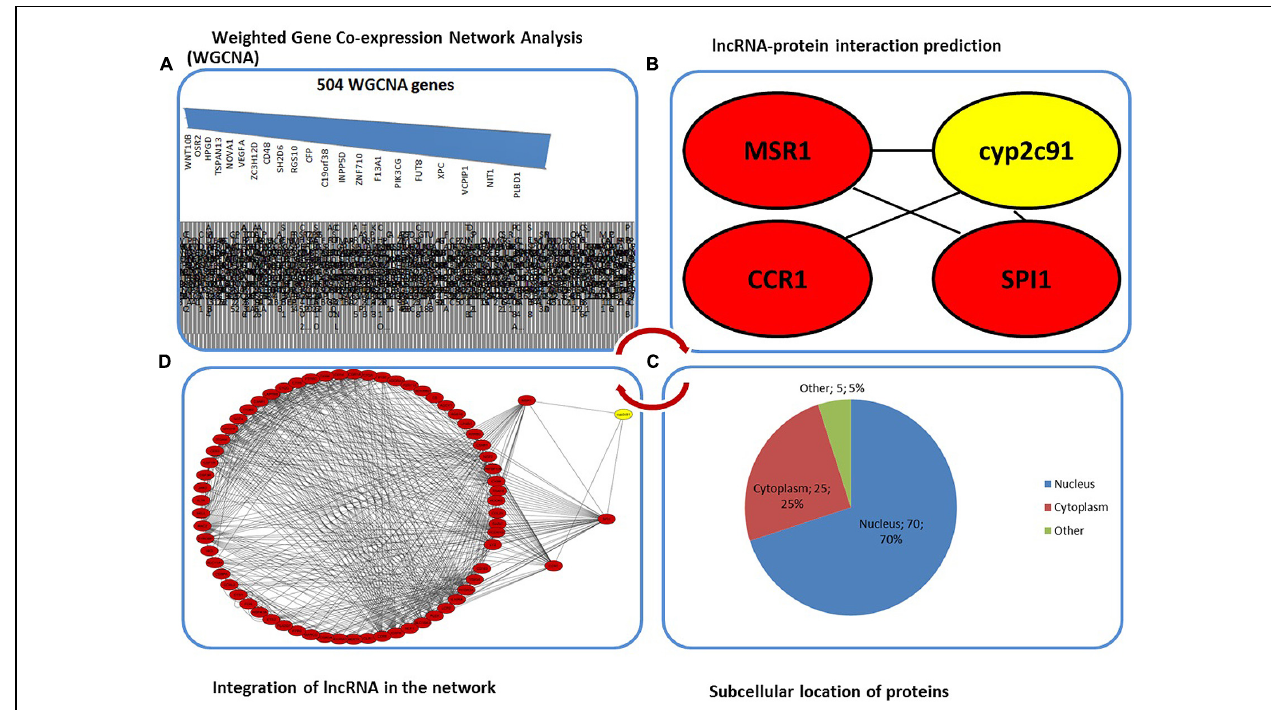
FIGURE 1 | (A) The 504 genes from WGCNA across different modules linked to diseases not limited to obesity and immune response. (B) Representative lncRNA cyp2c91 gene (in yellow) shown to be interacting with three regulatory protein-coding genes predicted from RPI-pred. (C) Subcellular location of the